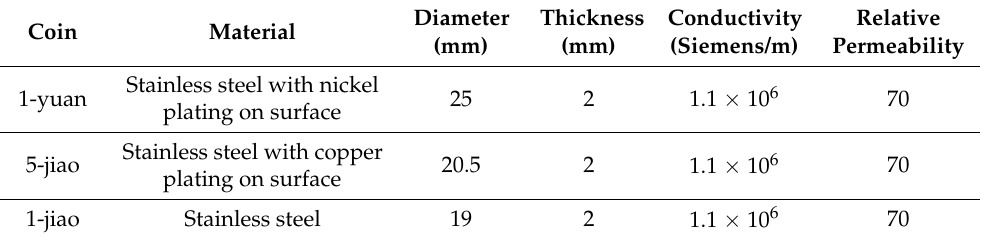
Figure 19. The detection sensitivity S of different foreign objects which are placed in the center position and corner position of detection coil. Table 2. The size and the electromagnetic parameters of the selected